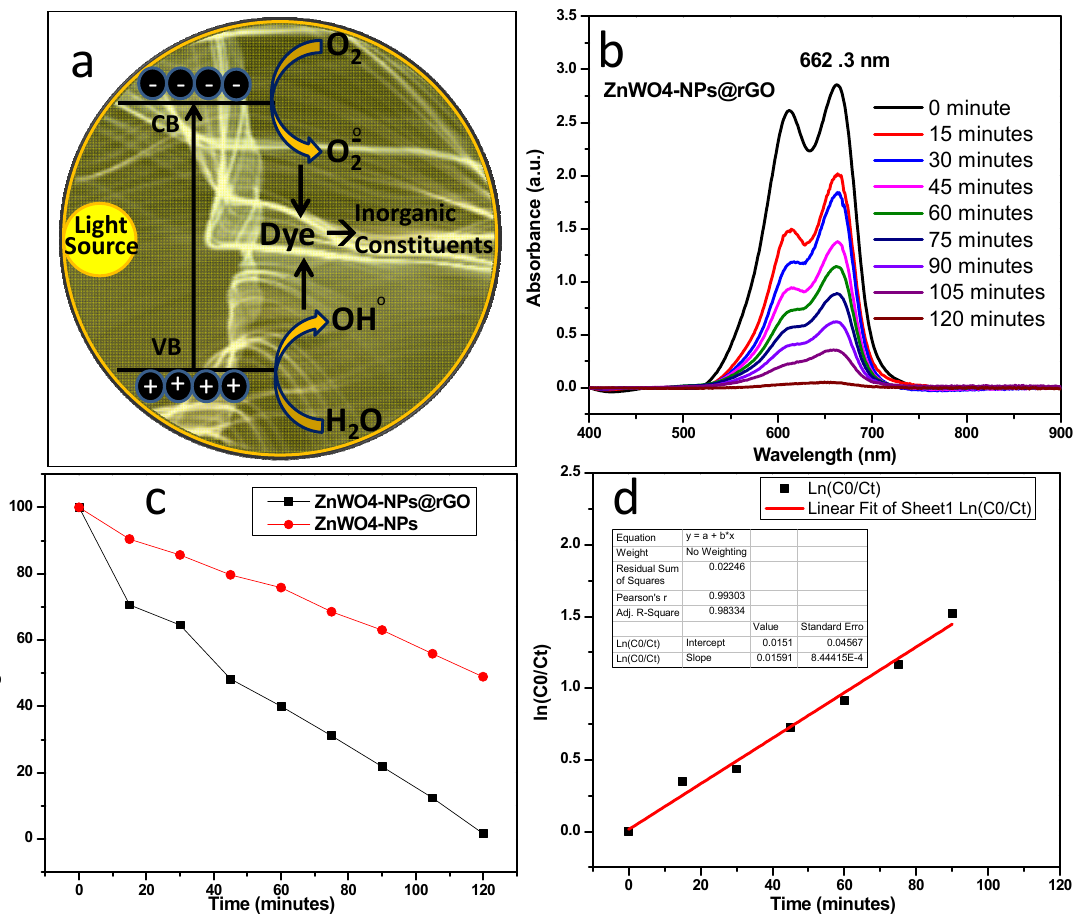
Figure 6. ( a ) Reaction scheme, ( b ) absorption spectra, ( c ) percent degradation, and ( d ) linear plot of photo-degradation of HMBD using ZnWO 4 -NPs@rGO nanocomposites.